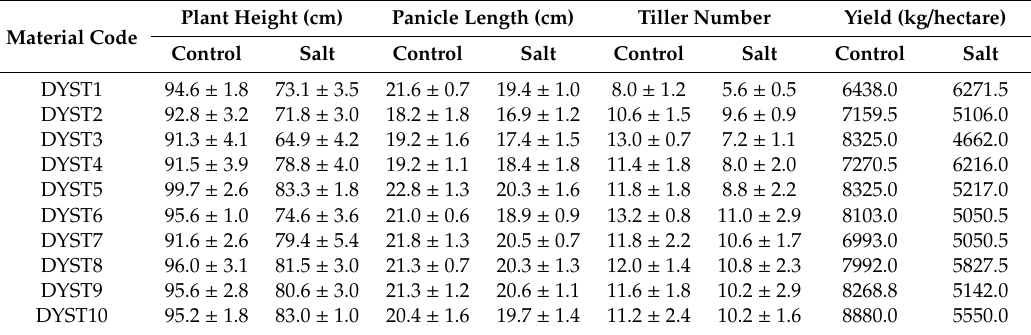
Table 1. Rice varieties with excellent agronomic traits and salt tolerance